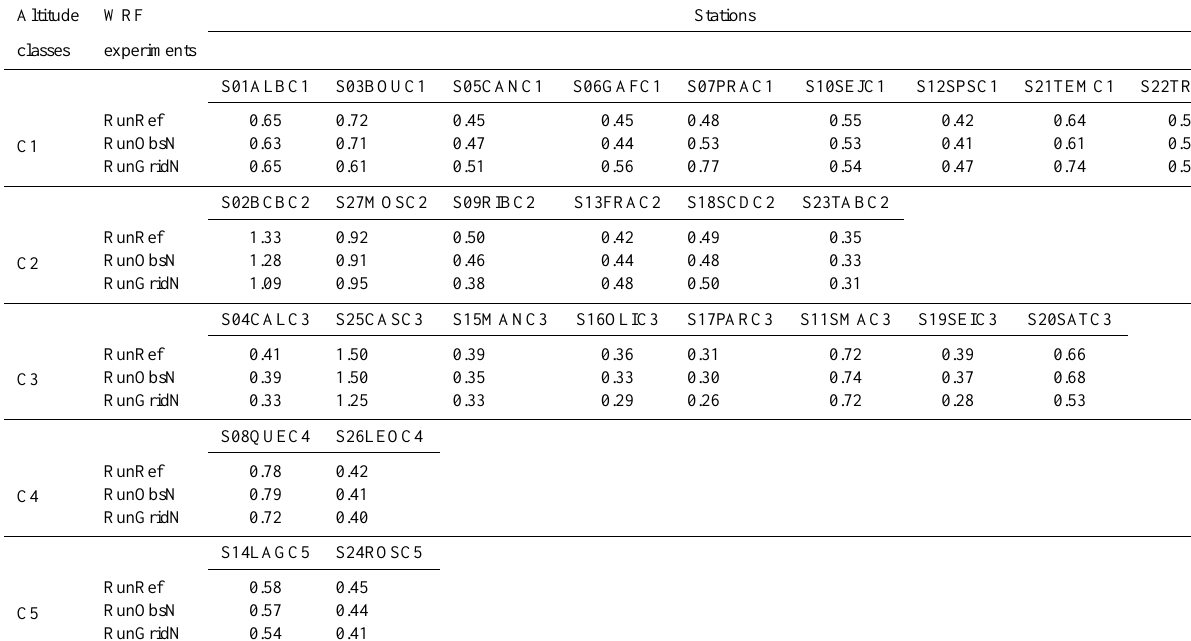
Table 6. Mean absolute error (MD) between the simulations and the observations for each location grouped by altitude class. Altitude WRF Stations classes experiments